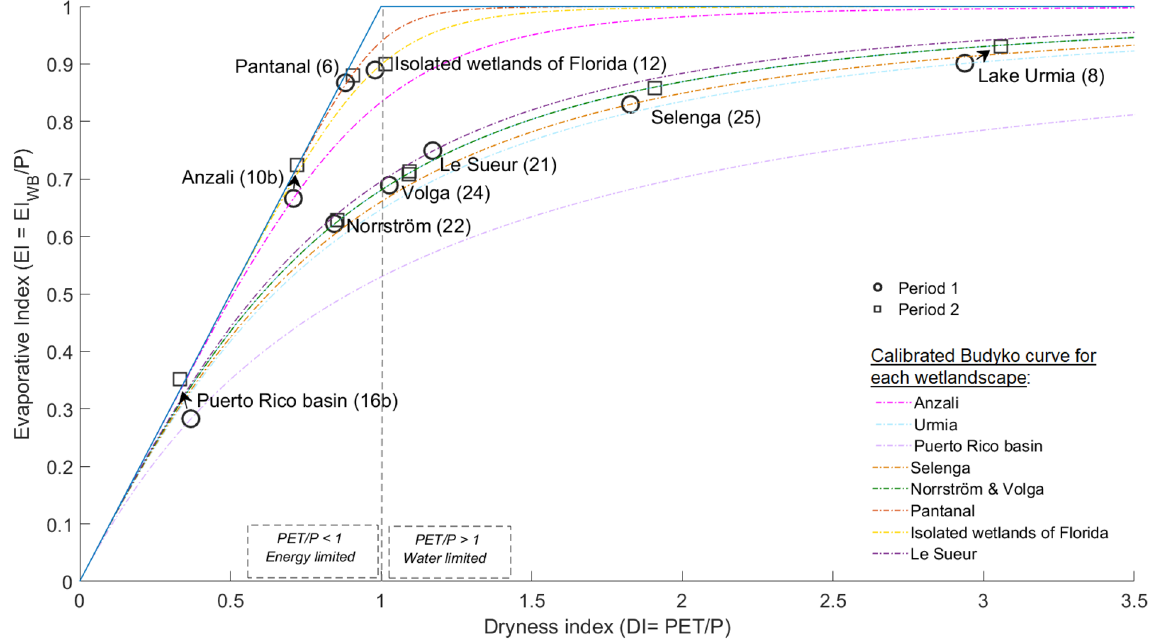
Figure 4. Wetlandscape hydro-climatical conditions presented in the Budyko space. Relation between the evaporative and dryness index for the first (circle point) and the second period (box point) of the studied time period for all the different wetlandscape with available Q data. All wetlandscapes are represented with a calibrated Budyko curve representing their region specific climatic